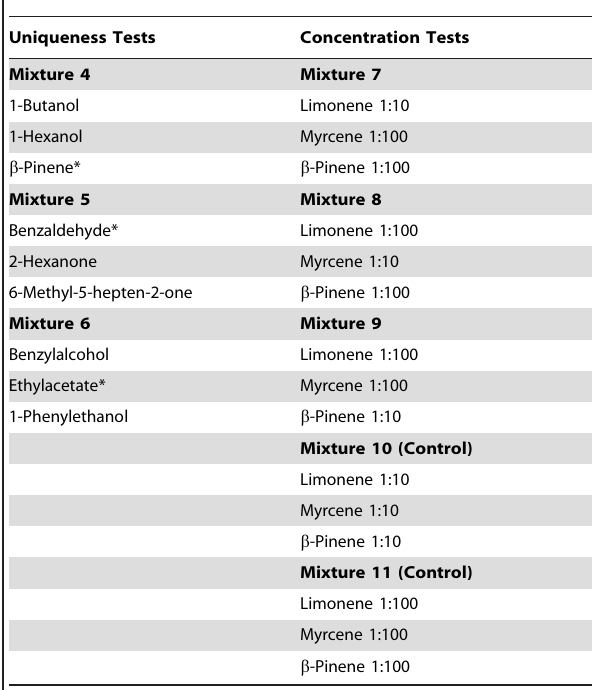
Table 6. Composition of Odour Mixtures for Odorant Uniqueness and Odorant Concentration